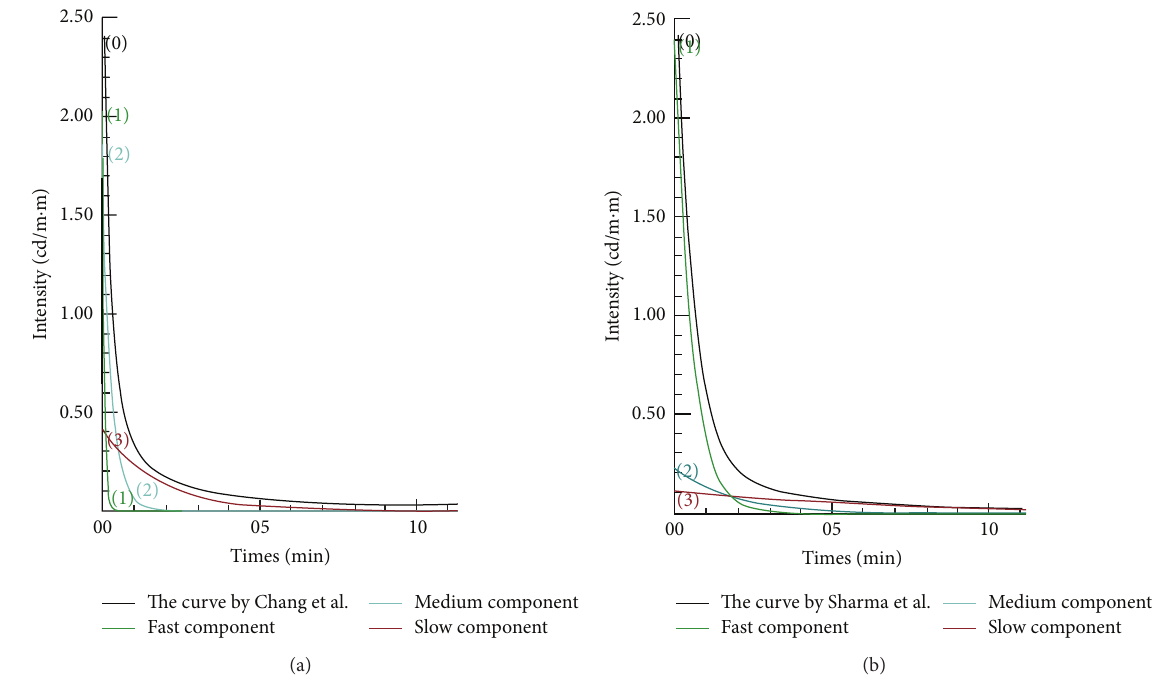
Figure 1: The figures of fast, medium, and slow component in an equation. Data cited from [12, 17].